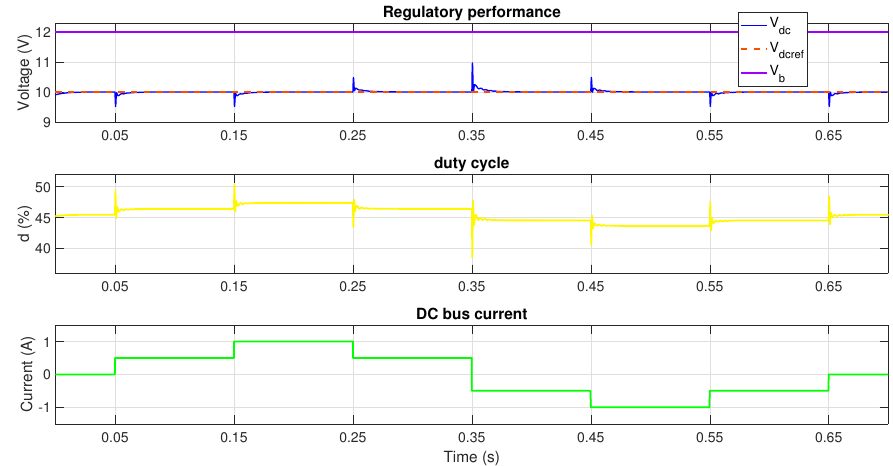
= 10 V (buck mode). ref